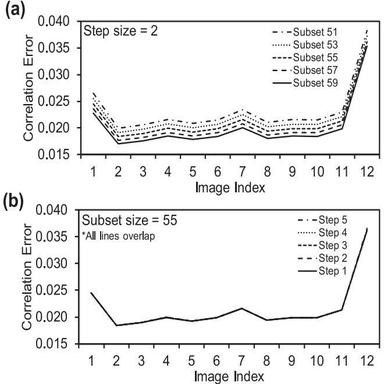
Relationship between correlation error and (a) subset size and (b) step size. μDIC was performed on MS1500 images up to the last image (12) prior to fracture at 10,000× magnification.